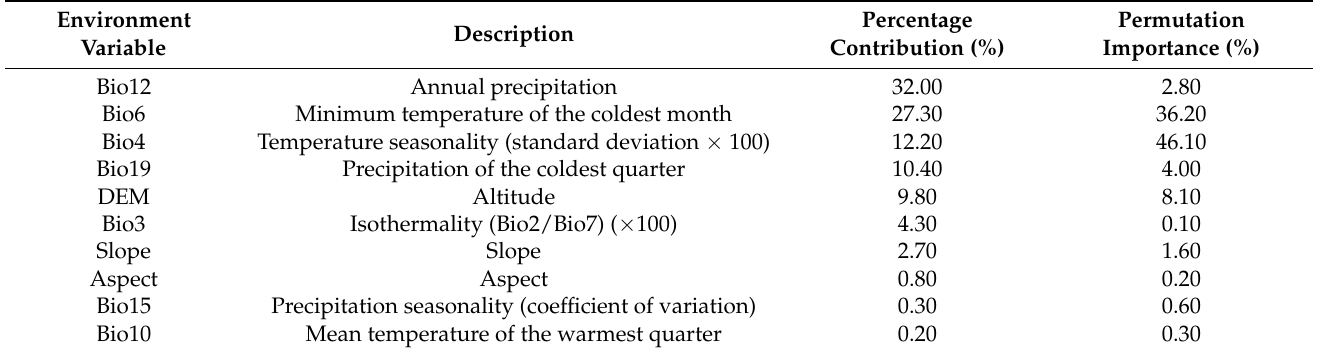
Table 2. The percentage contributions and permutation importance values for environmental